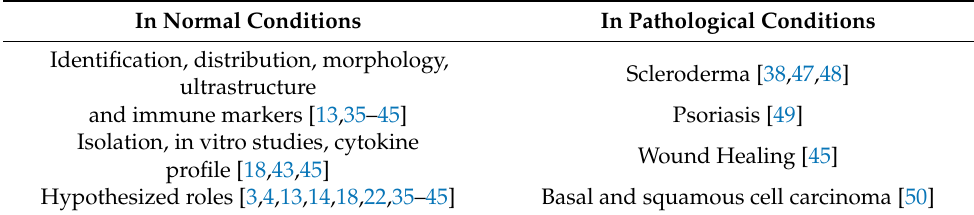
Table 1. Contributions about CD34+SCs/TCs in the skin. In Normal